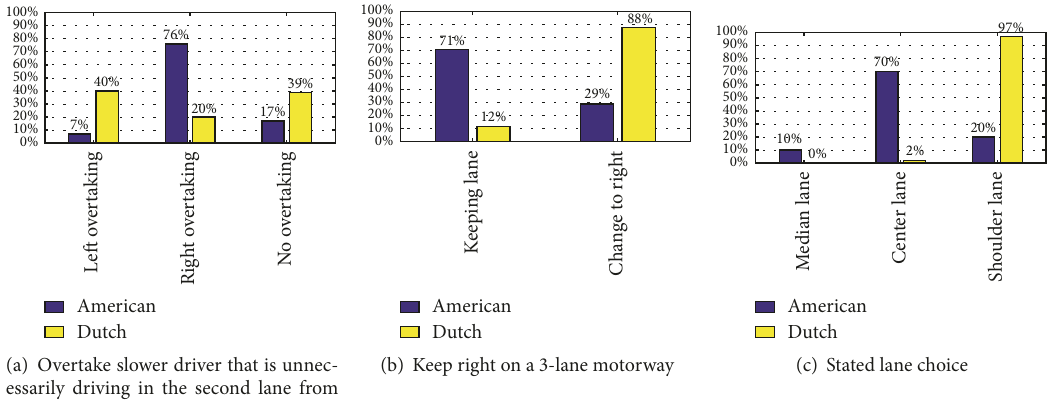
Figure 5: Differences in lane choice for US